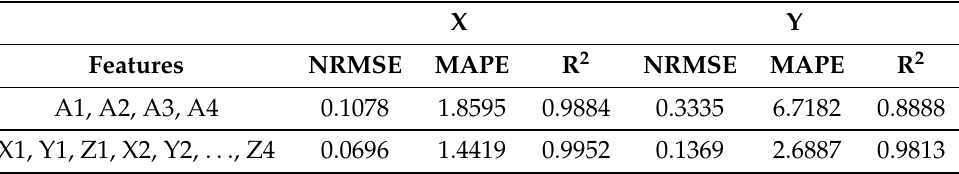
Table 4. Estimation of X and Y using different features. X Y Features NRMSE MAPE